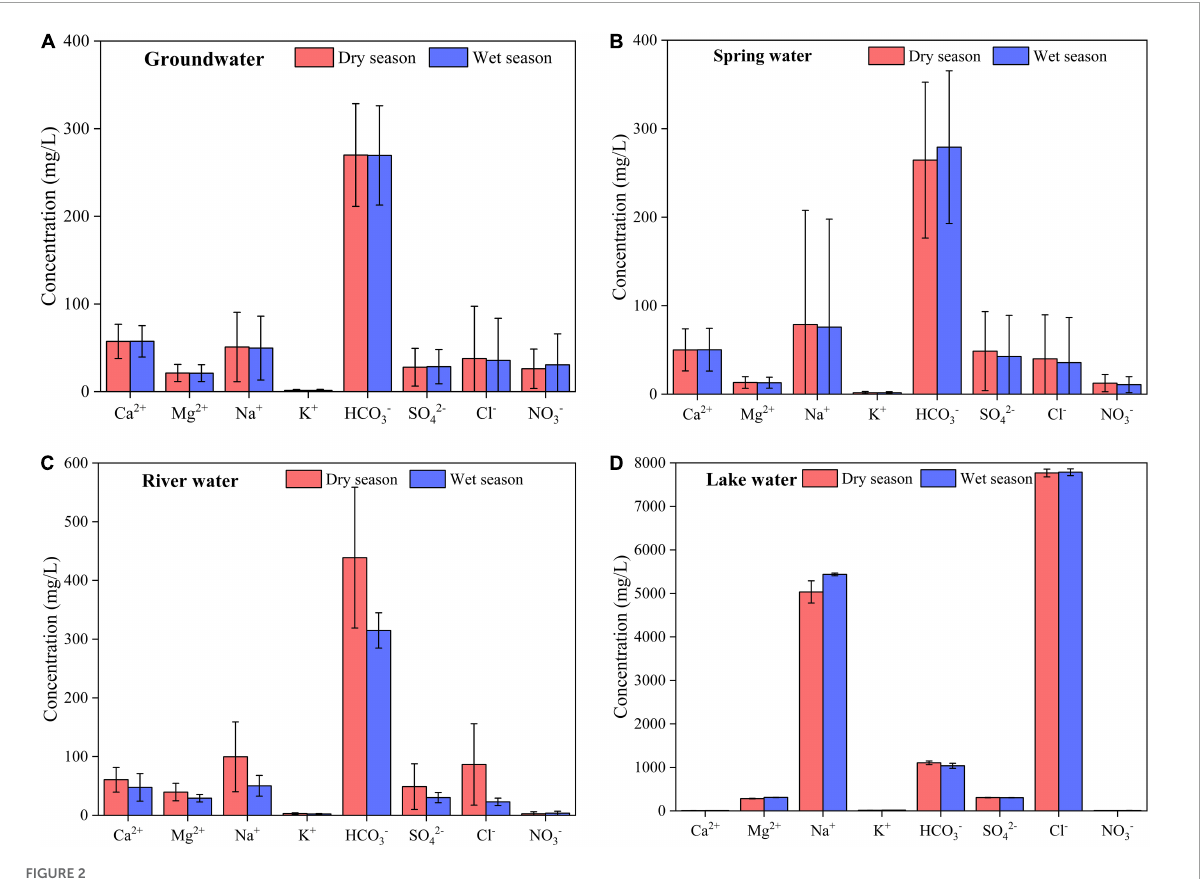
FIGURE2 Ion concentrations of in groundwater (A) , spring water (B) , river water (C) , and lake water (D)